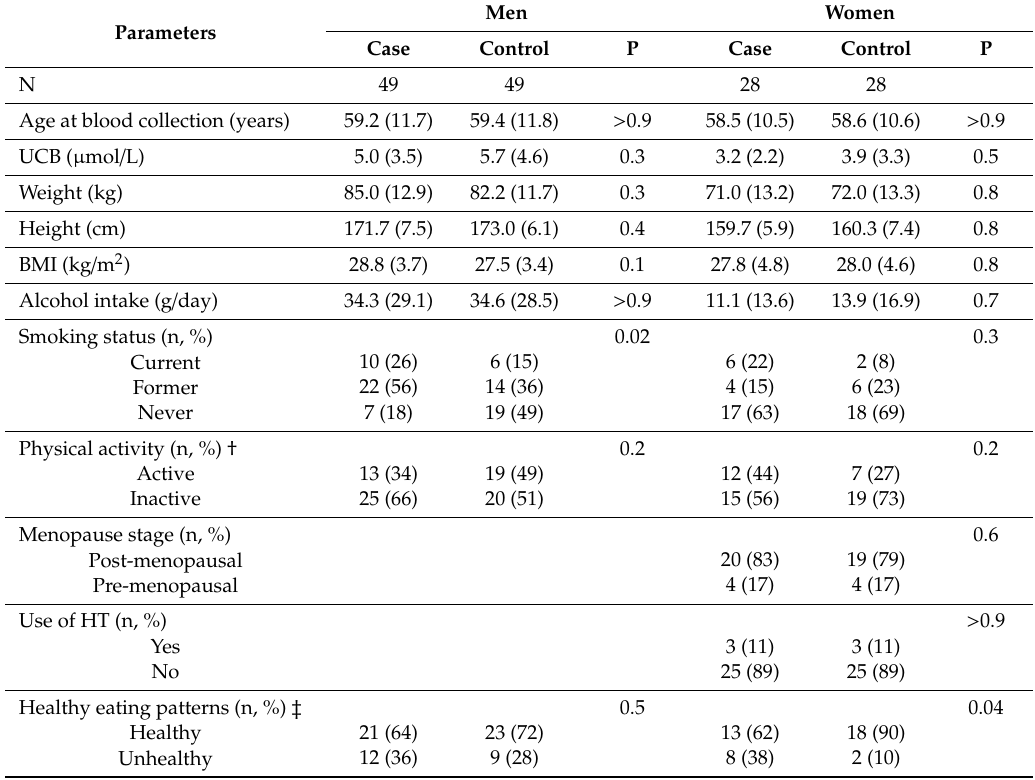
Table 1. Baseline characteristics of colorectal cancer cases and their individually matched controls by sex in the Cooperative Health Research in the Region of Augsburg (KORA) nested case-control study.